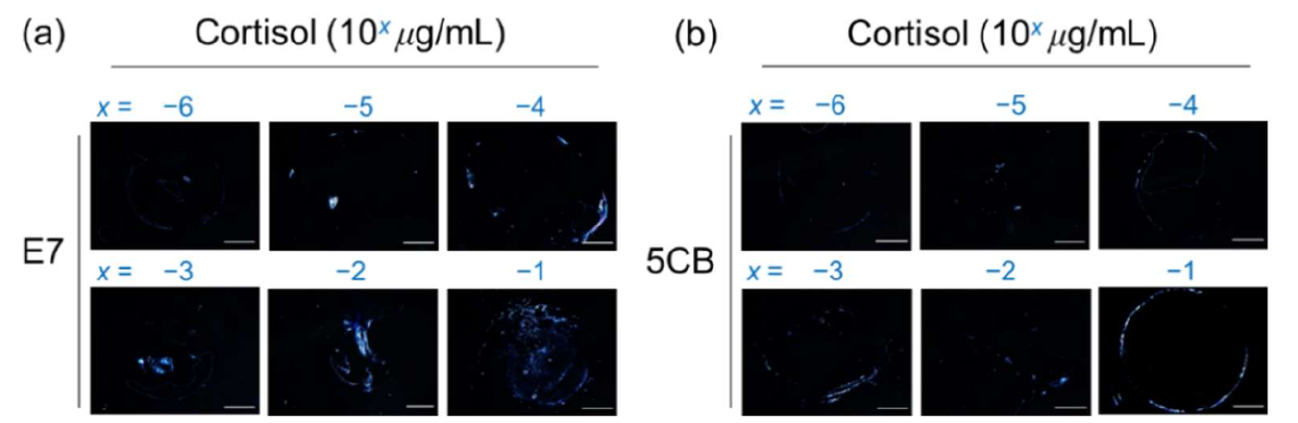
Figure 7. Optical texture of ( a ) E7 and ( b ) 5CB at various concentrations of cortisol on glass substrates coated with the PVA/DMOAP composite. Aqueous solutions of cortisol at various concentrations (10 − 6 –10 − 1 µ g/mL) were immobilized on PVA/DMOAP-coated glass substrates for LC-based detec- tion with E7 or 5CB as the sensing medium. Scale bar: 500 µ